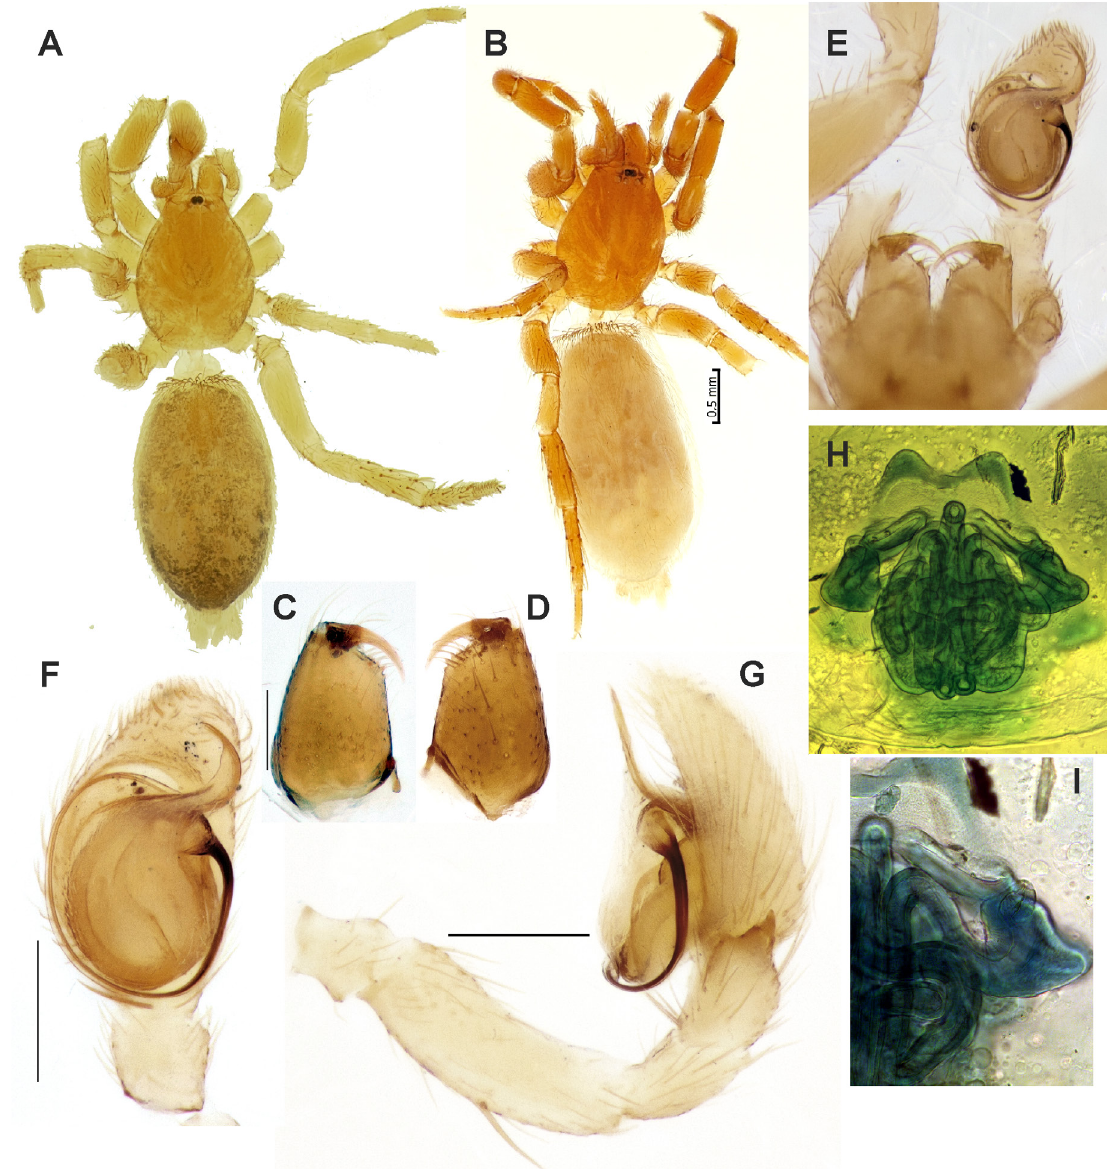
Fig. 22. Synaphosus martinezi sp. nov. (A, C–G = holotype, ♂, MHNG; B, H–I = paratype, ♀, MHNG). A–B . Habitus, dorsal view. C–D . Chelicera, posterior and anterior views. E–G . Palp, ventral and retrolateral views. H–I . Epigyne, dorsal view. Scale bars: 0.2 mm, unless stated